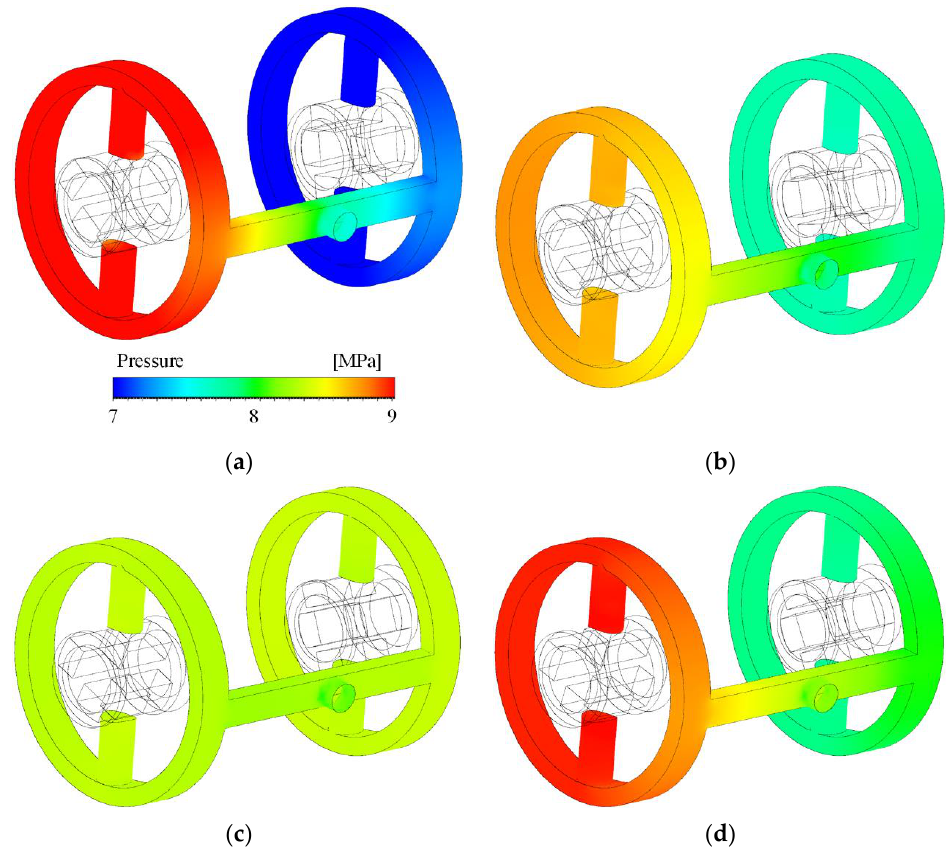
Figure 15. Pressure distributions in the outlet fluid zone when the pump rotates to ( a ) 7.2 deg, ( b ) 10.8 deg, ( c ) 14.4 deg, and ( d ) 18 deg.